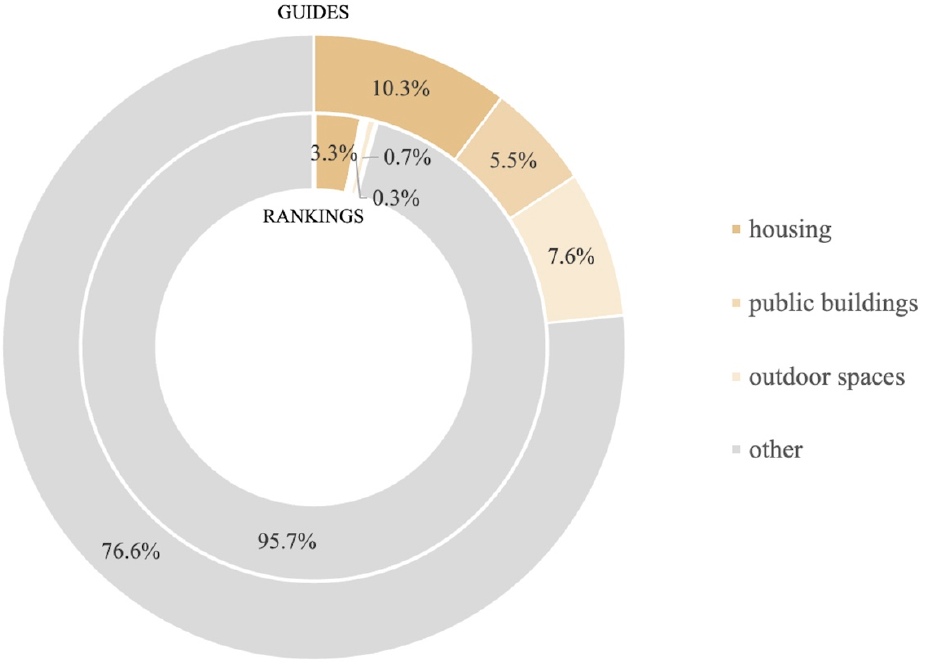
Figure 4. Share of the “housing”, “public buildings”, and “outdoor spaces” criteria in reference to other criteria used in the guidelines and rankings.